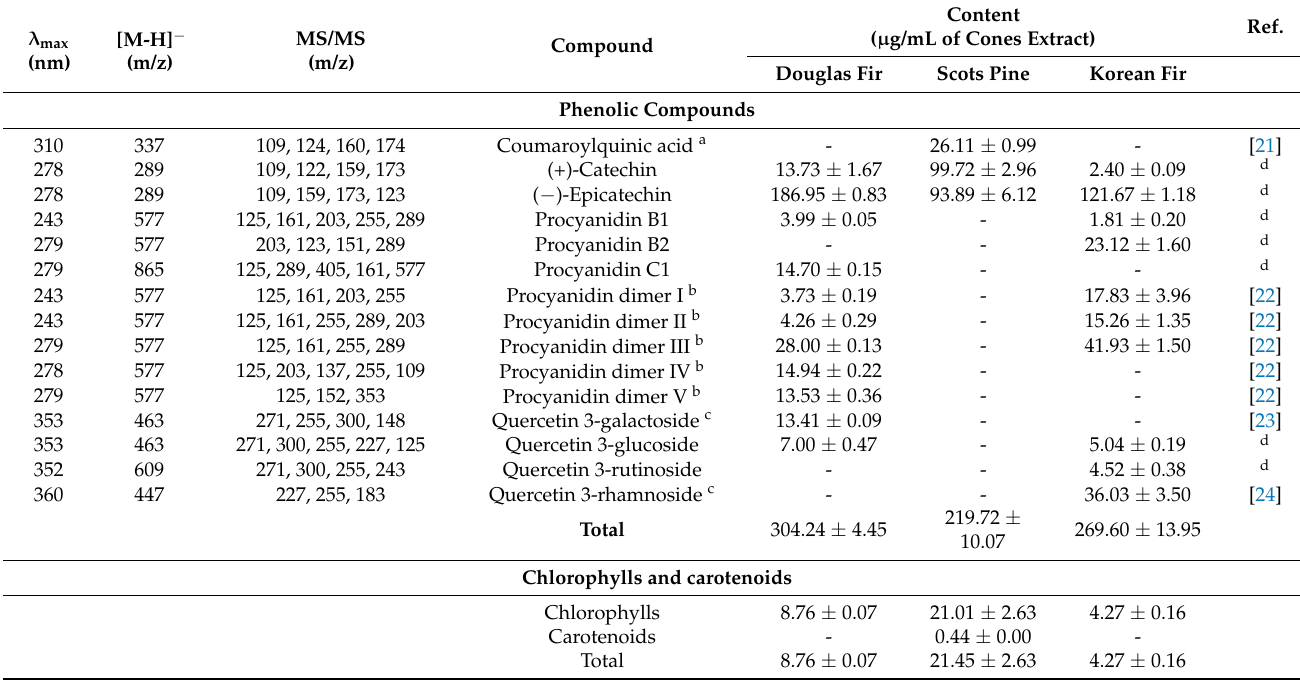
Table 1. Phenolic compounds, chlorophylls and carotenoids contained in cone